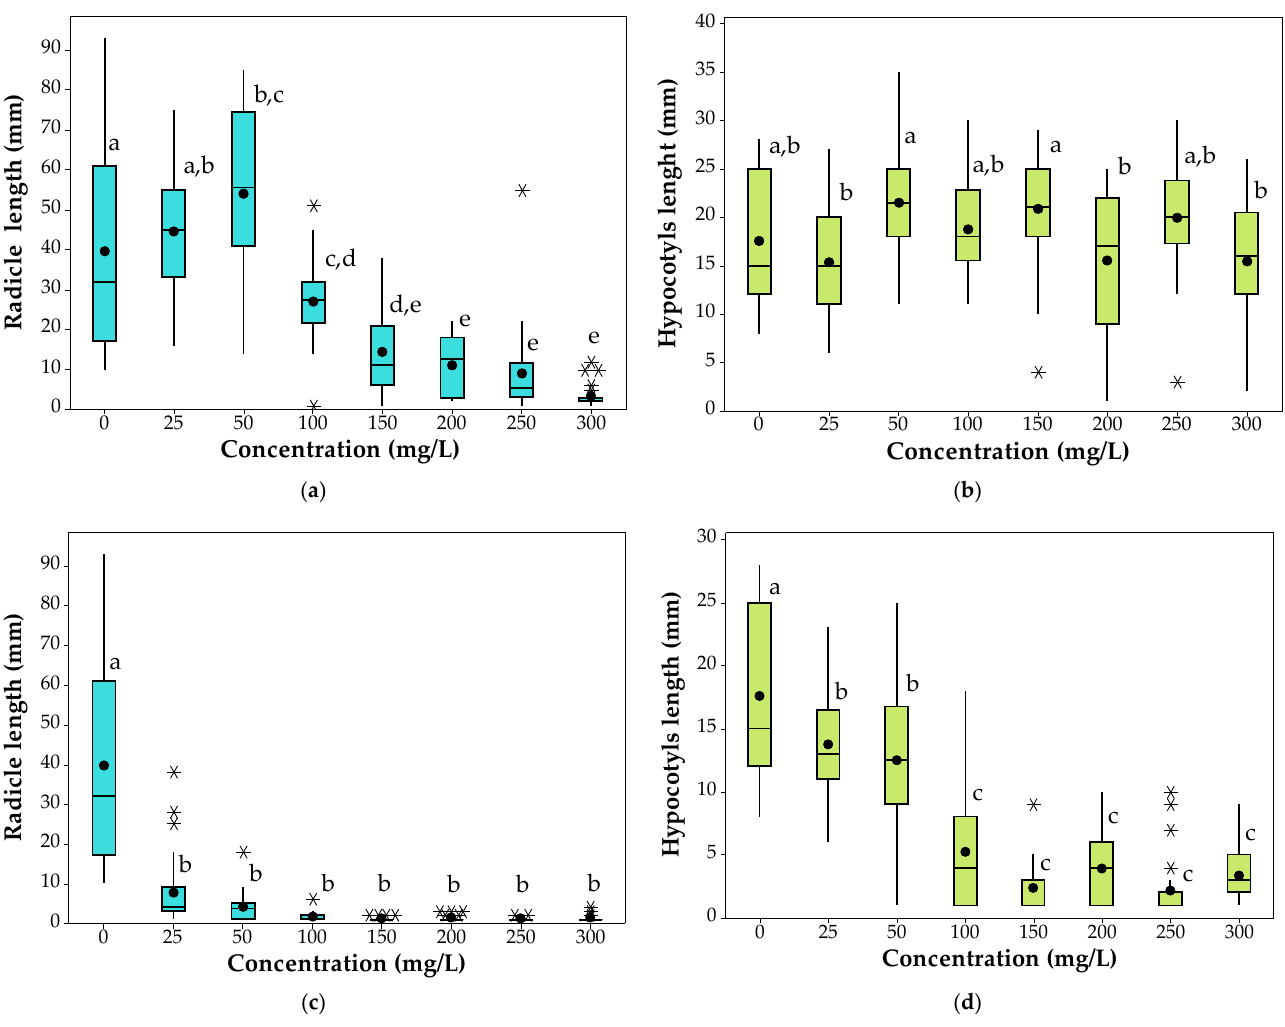
Figure 5. Box and whisker plots for ( a ) radicle and ( b ) hypocotyl length of Brassica napus L. at different levels of Pb(II) in solution and ( c ) radicle and ( d ) hypocotyl length at different levels of Cd(II) in solution. Box plots represent median (line inside each box) and the bottom and top of boxes represent the lower and upper quartiles, respectively. The mean is indicated with a (●) and the bottom and top of each whisker represent the minimum and maximum of each observed trait, respectively. ( ✳ ) represents the outliers. Means that do not share a letter are significantly different, according to Tukey HSD test ( p < 0.05).